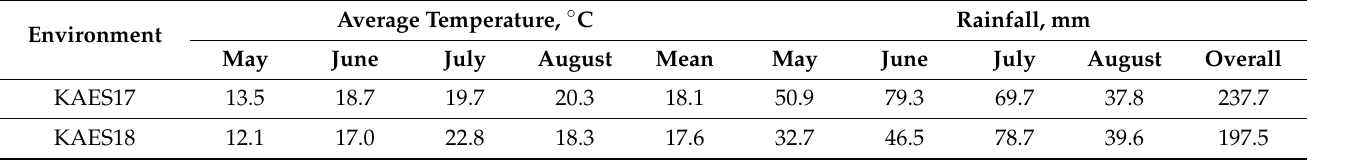
Table 10. Rainfall and temperature during vegetation periods in 2017 and 2018 at Karabalyk Agricul- tural Experimental